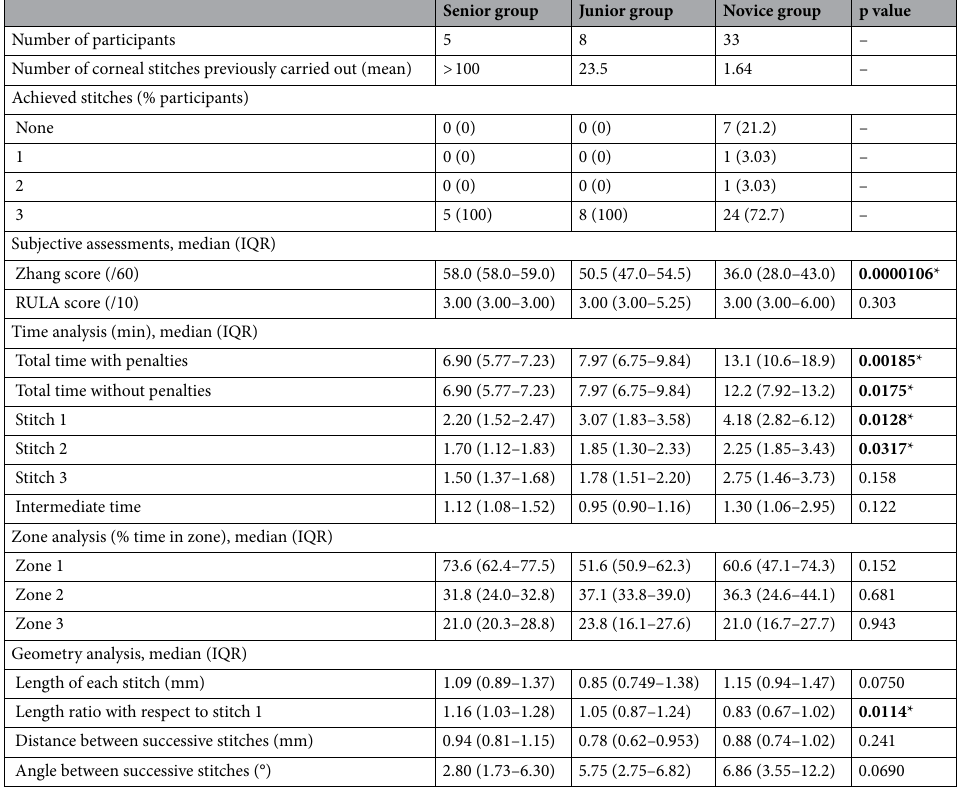
Table 1. Characteristics of the performance of Senior, Junior and Novice groups during a corneal wound closure task, according to type of analysis. IQR interquartile range, mm millimeters, RULA Rapid Upper Limb Assessment. Significant values are in